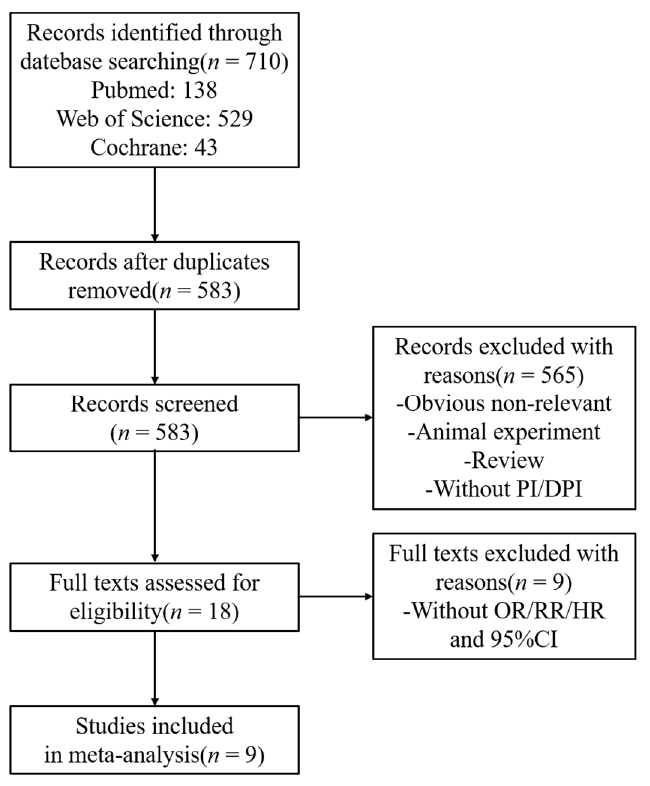
Figure 1. Flow chart of study selection. Abbreviations: PI: phytochemical index; DPI: dietary phy-